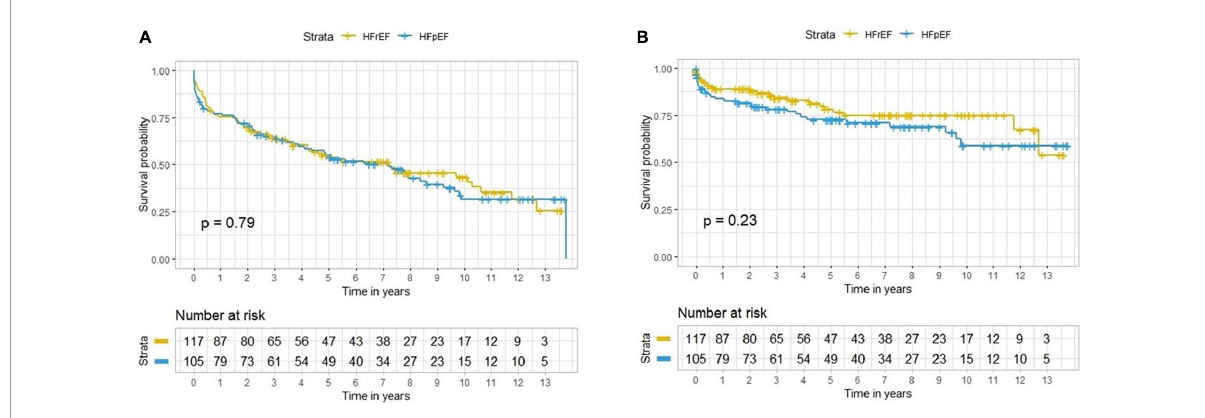
FIGURE2 Survival curves for all-cause mortality (A) and CV death (B) in participants with HFrEF and HFpEF.